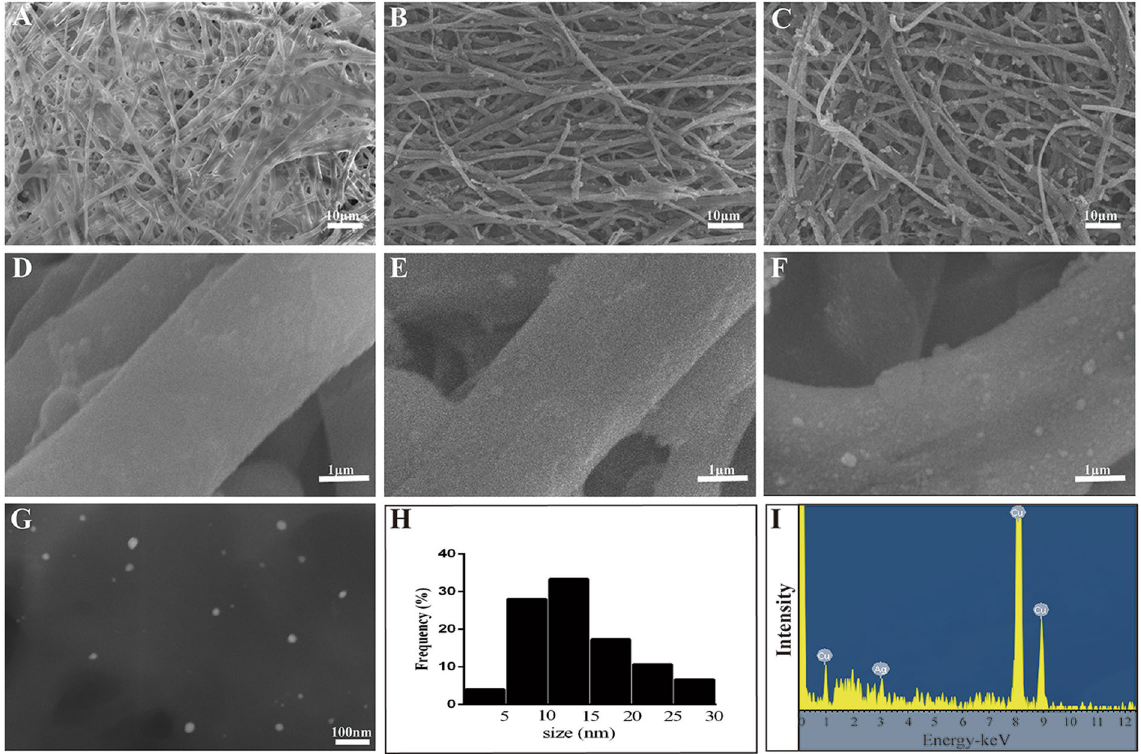
Figure 3. Characterization of the EM/AgNPs nanocomposite. SEM images of ( A , B ) EM, ( C , D ) EM/PD and ( E , F ) EM/AgNPs. ( G ) STEM images of AgNPs released from EM/AgNPs, ( H ) the size distribution of AgNPs, and ( I ) AgNPs EDS analysis result: the peak at 3 keV corresponds to Ag element, and the peaks at 1 keV, 8 keV and 9 keV correspond to Cu element (n =